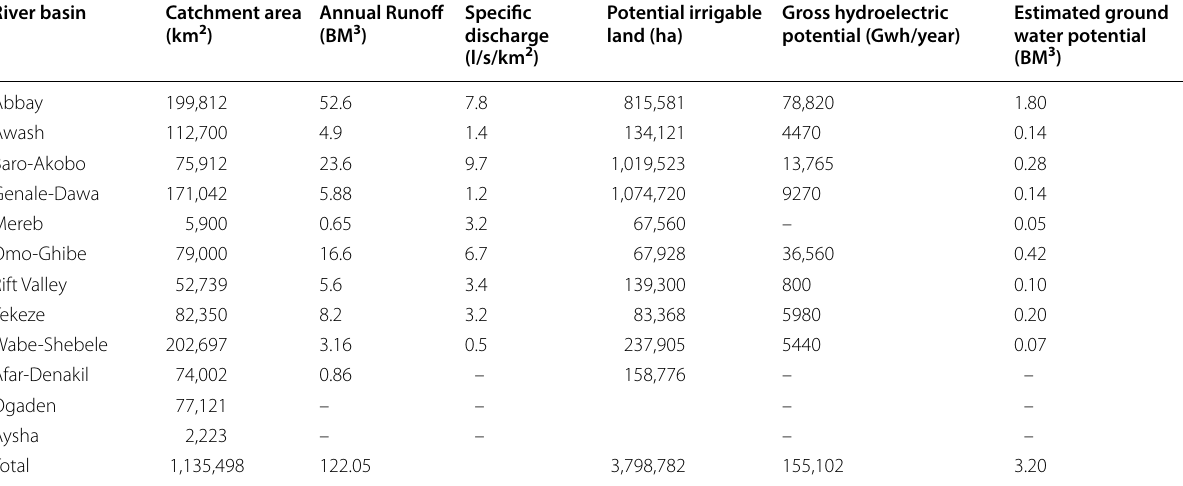
Source: Compiled from Awulachew et al. (2007) and MoWR (2002)